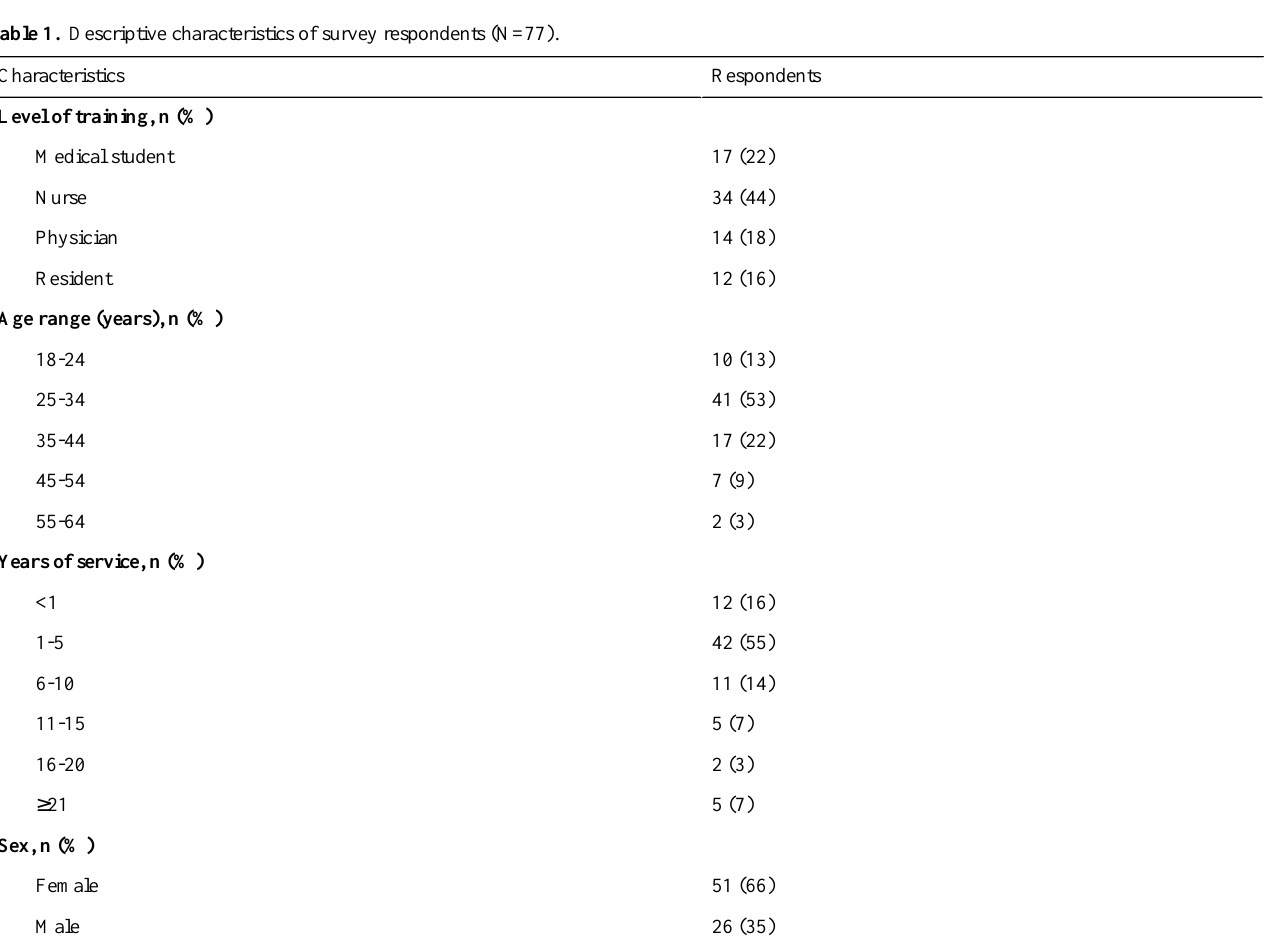
Table 1. Descriptive characteristics of survey respondents